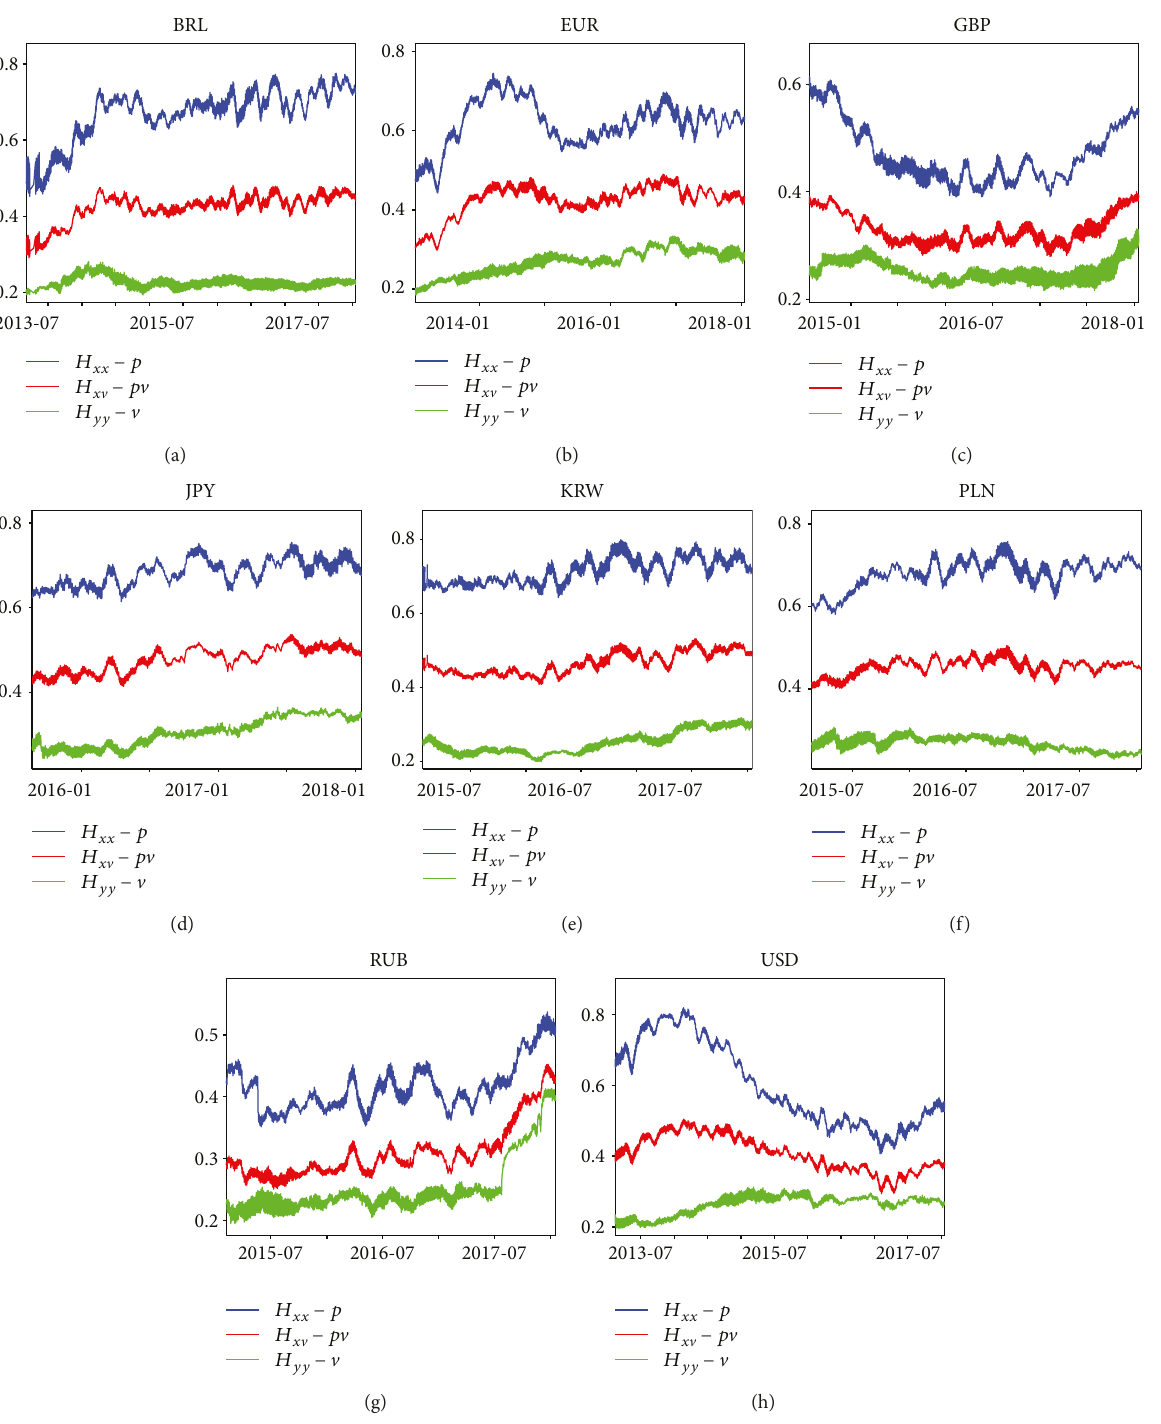
Figure 12: Time varying scaling exponents when q = 2